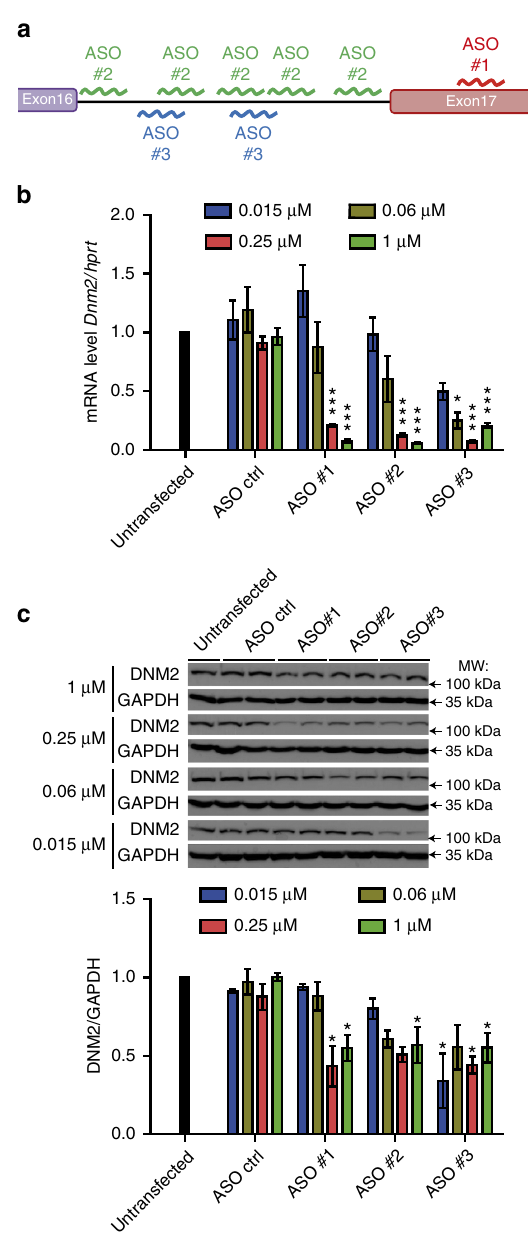
Figure 1 | In vitro validation of ASOs targeting Dnm2 . ( a ) Location of ASO-targeting sequences in Dnm2 mouse pre-mRNA. ( b ) Dnm2 mRNA level in ASO-treated C2C12 myoblast cells was determined by qRT-PCR and standardized to Hprt . Cells were electroporated with ASO control (ctrl), #1, #2 or #3 at 0.015, 0.06, 0.25 or 1 m M and collected 24h later. ( c ) Representative western blot from the same C2C12 cells for DNM2 and the GAPDH loading control. Below, DNM2 protein levels was determined by densitometry and standardized to GAPDH. n ¼ 3 per each group. Data represent an average of three independent experiments ± s.e.m. * P o 0.05, *** P o 0.001 for ASO Dnm2 -treated versus ASO ctrl-treated cells (ANOVA test). kDa, kilodalton; MW, molecular weight.